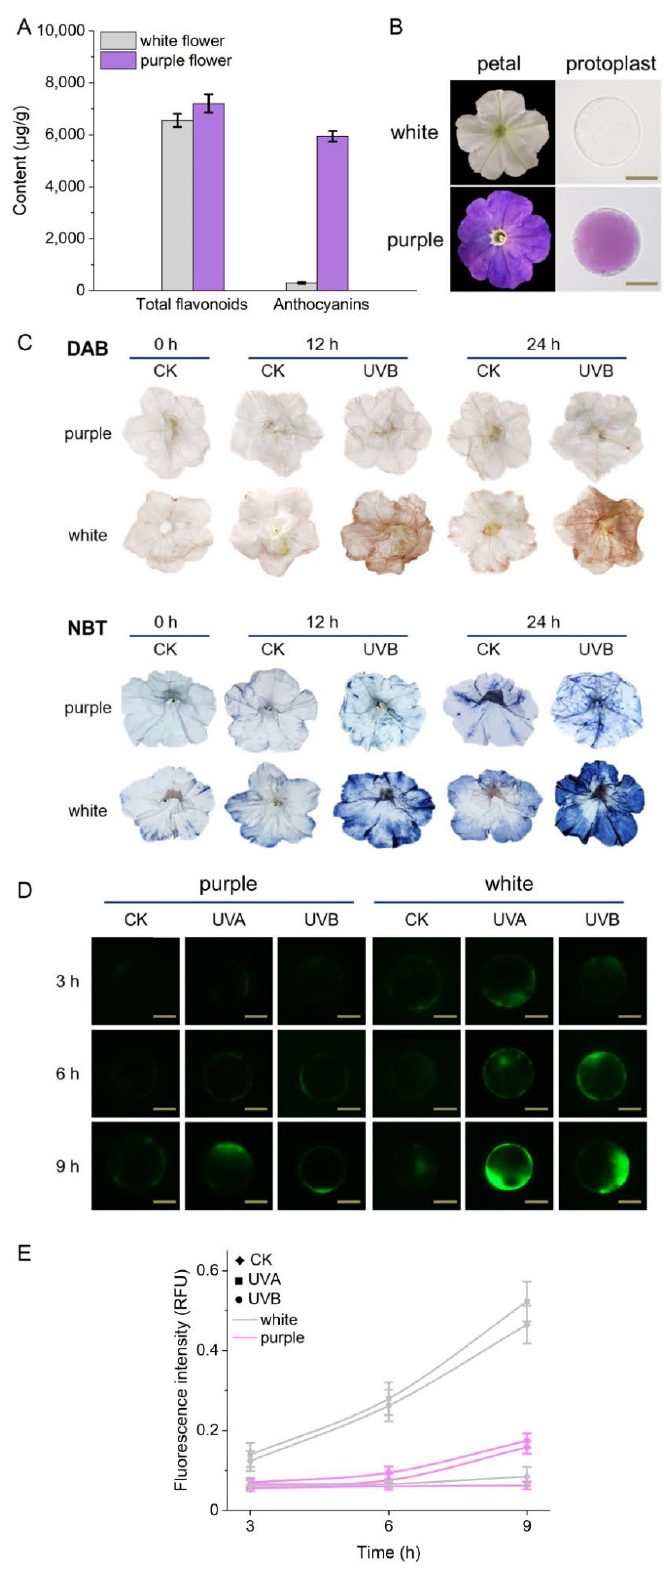
Figure 4. Response of Petunia protoplasts to UV irradiation. ( A ) Total flavonoid and anthocyanin content in different colored petals; ( B ) images of petals at tissue and cell levels; ( C ) DAB and NBT staining of different colored petals under UV irradiation; ( D ) fluorescence images of protoplasts ROS with a scale of 25 µ m; ( E ) fluorescence intensity of different colored protoplasts on